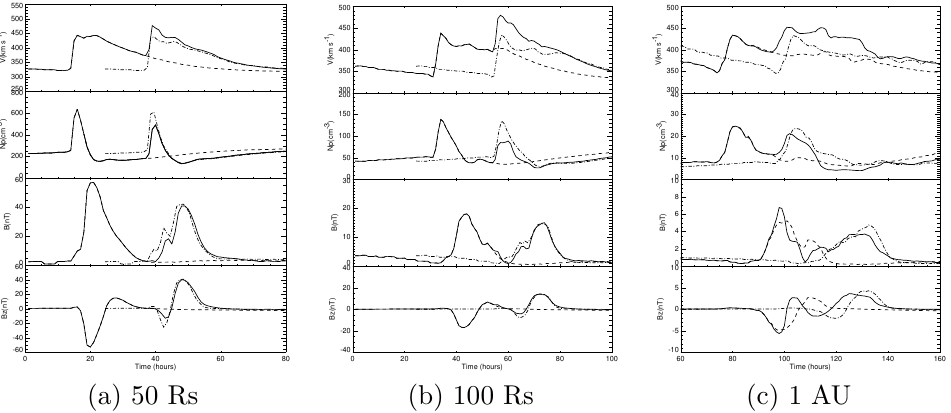
Figure 5. Profiles of velocity, density, magnetic field and south component of magnetic field as function of time at different heliospheric distances: ( a ) 50 R s ( b ) 100 R s and ( c ) 1 AU for CME1 (dashed line), CME2 (dash-dotted line) and CME12 (solid